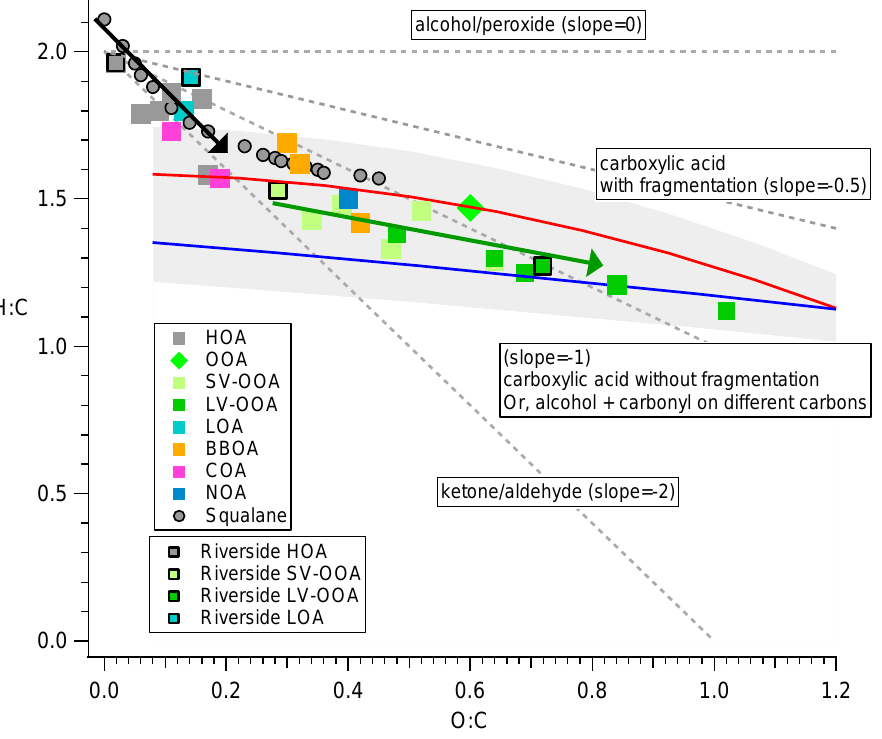
Fig. 6. VK-triangle diagram for the OA components from all sites with HR-AMS data and results from the heterogeneous oxidation of squalane. The light gray shaded region denotes the ± 10% uncertainty in the parameterization. (Note: LOA=local OA; BBOA=biomass burning OA; COA=cooking OA; NOA=nitrogen-enriched